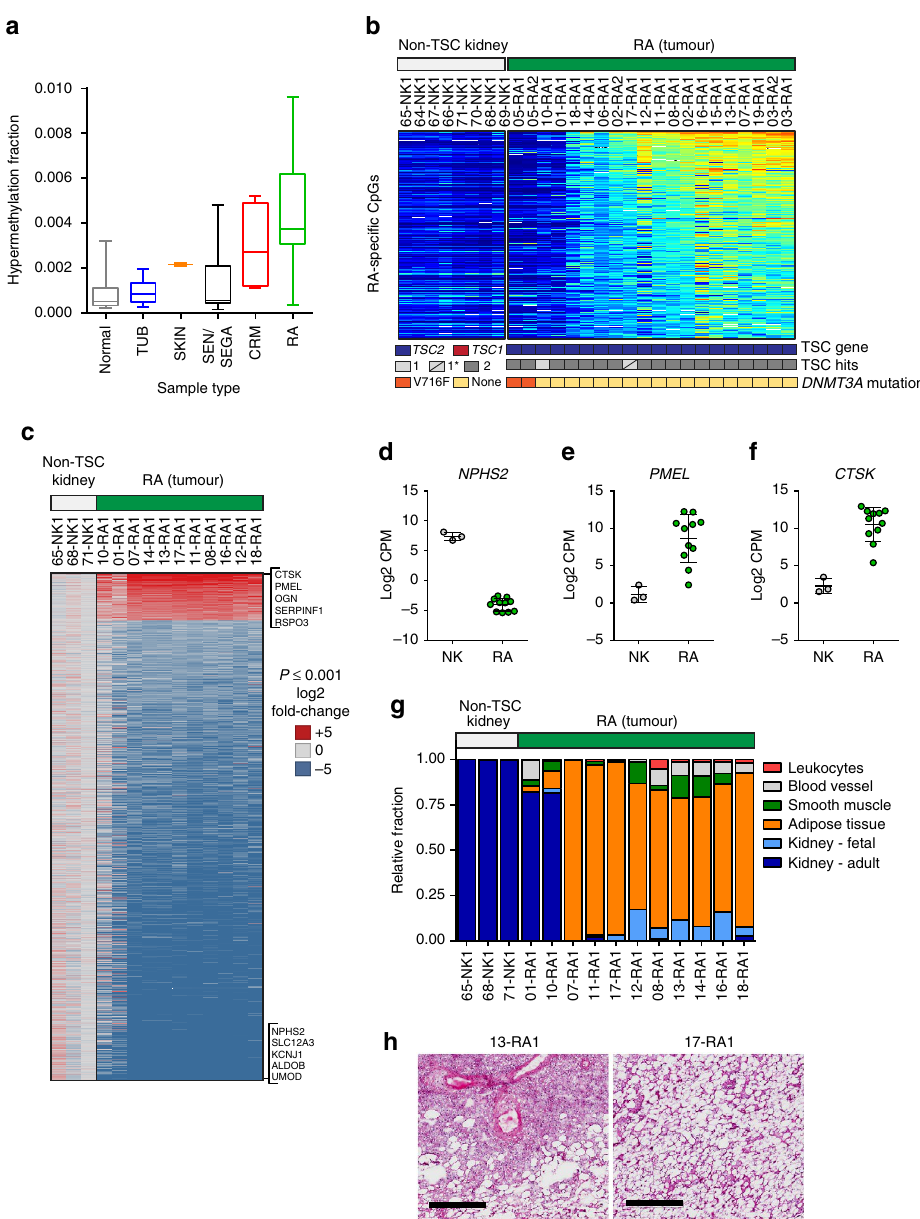
Figure 3 | Shared methylation and transcriptional features of angiomyolipomas. ( a ) The hypermethylation fraction of TSC tumours (boxes: 25th to 75th percentile; whiskers: minimum to maximum; line: median). ( b ) 240 RA-specific probes. Probe signal intensity shown from low (blue) to high (red). Samples annotated for germline mutation (blue: TSC2 ; red: TSC1 ), 1 or 2 TSC hits (germline þ somatic mutation) with ‘1*’ indicating only 1 mutation found but data from targeted TSC1/TSC2 sequencing not available, and DNMT3A status (yellow: wild-type; orange: V716F somatic mutation). ( c ) Genes differentially expressed in RA tumours compared to non-TSC kidney samples (log2 fold-change þ / (cid:2) 4 2; adjusted P o 0.001) coloured by log2 fold-changes according to the scale (blue: low; red: high). Top 5 upregulated and downregulated DEGs are indicated. ( d – f ) Normalized log2 CPM values for NPHS2, PMEL and CTSK for non-TSC kidney (NK; grey) and RA (green). Symbols represent single samples. Line: mean; error bars: s.d. ( n ¼ 3 non-TSC kidney; n ¼ 11 RA). ( g ) The relative fraction of cell types estimated by CIBERSORT (red: leukocytes; grey: blood vessel; green: smooth muscle; orange: adipose; light blue: fetal kidney; dark blue: adult kidney). ( h ) H&E-stained tissue sections of 13-RA (showing smooth muscle surrounding vasculature and pockets of adipose tissue) and 17-RA1 (nearly exclusive adipose tissue). Scale bars, 500 m